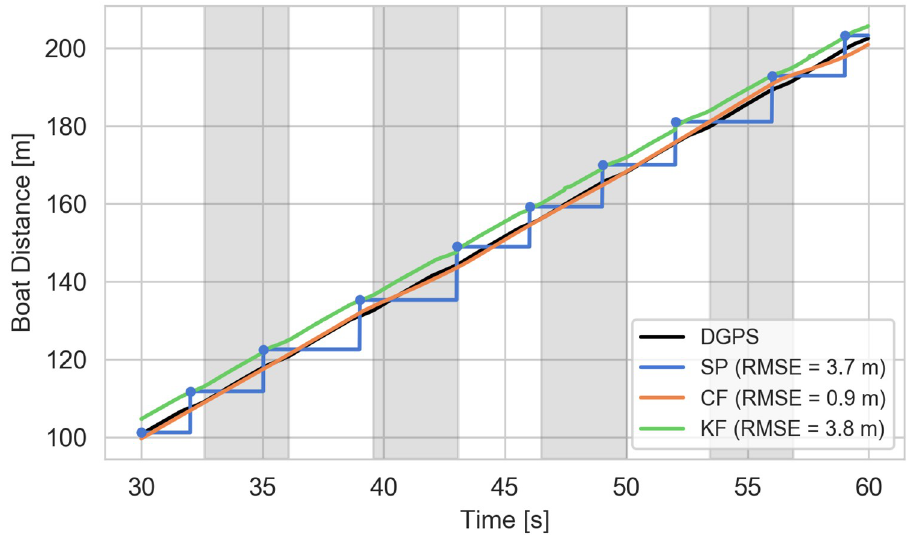
Fig 11. Example total boat distance traveled estimates. The figure indicates distance traveled as a function of time for the last 30 s of the elite 16NW trial as estimated by the smartphone, complementary filter, and Kalman filter. The blue dots indicate the actual smartphone measurement update and the blue line is the piecewise constant interpolation in between updates. The alternating gray and white sections indicate each stroke. The reported RMSE values are relative to the DGPS distance shown in black. Each RMSE is calculated at the accelerometer sampling rate, i.e. 100 Hz.